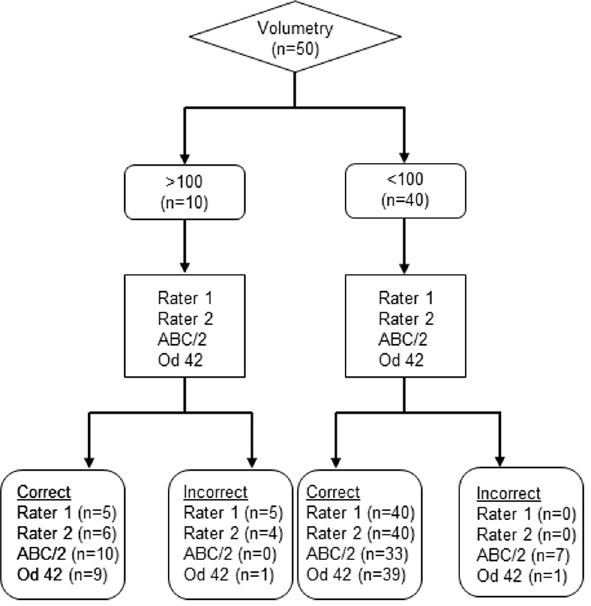
Fig 4. Flow diagram of the > 100 ml threshold. The 50 Patients from the compiled dataset were analyzed. The volumetry was considered gold standard and used as the index test. Then the other methods (Rater 1, Rater 2, ABC/2 and od-value 42) were used to estimate if the volume is > 100 ml, respectively < 100 ml.